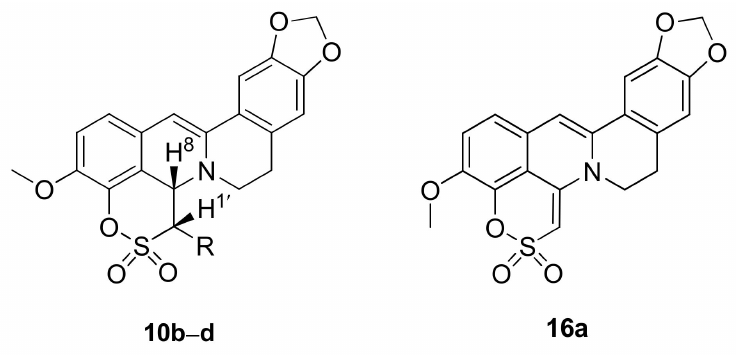
Figure 4. Structures of sultones 10b – d and dehidrosultone 16a .